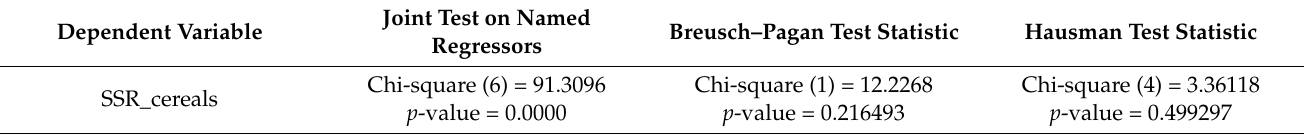
Table 3. Panel diagnostic